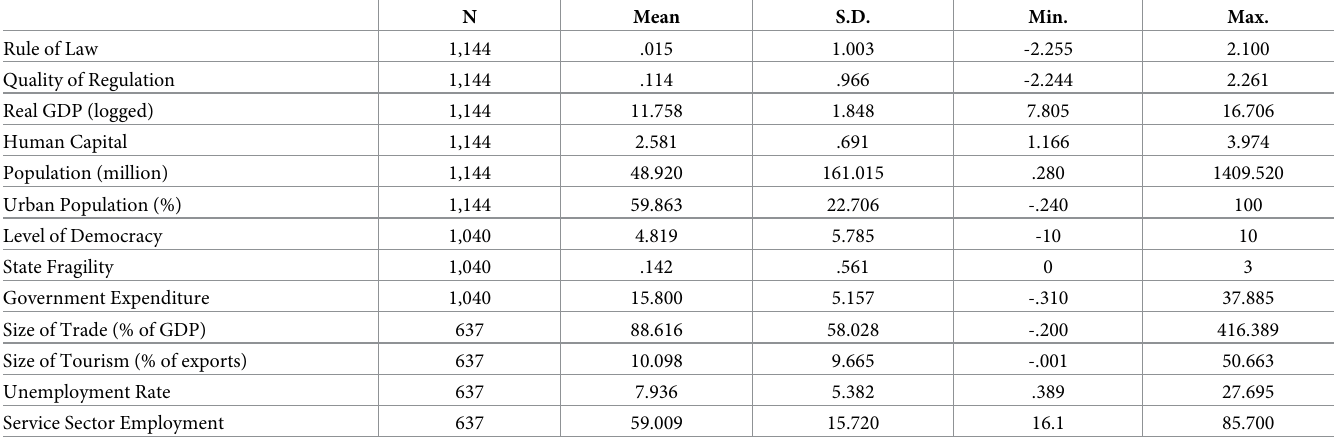
Table 1. Descriptive statistics of independent